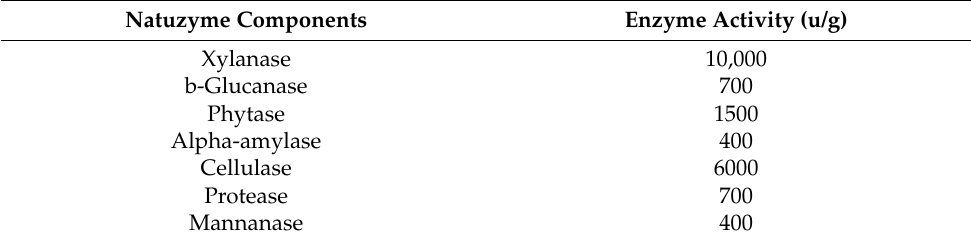
Table 3. Enzyme activity levels in Natuzyme